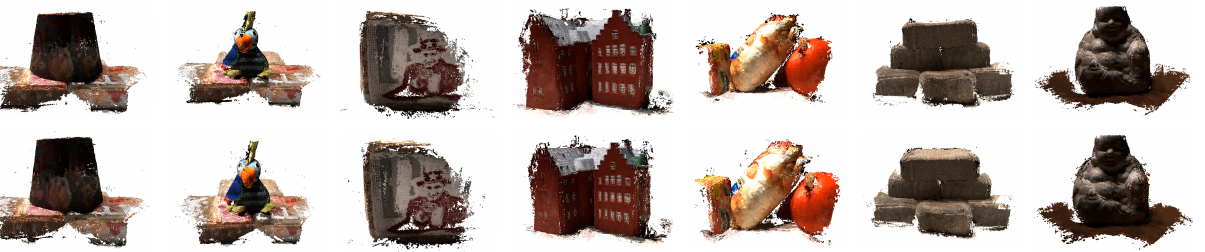
Figure 7. Effect comparison. The above image is the effect of the training of 0.05𝐻 ∙ 𝑊 sparse points. The below image is the effect of the training of 0.15𝐻 ∙ 𝑊 sparse points.